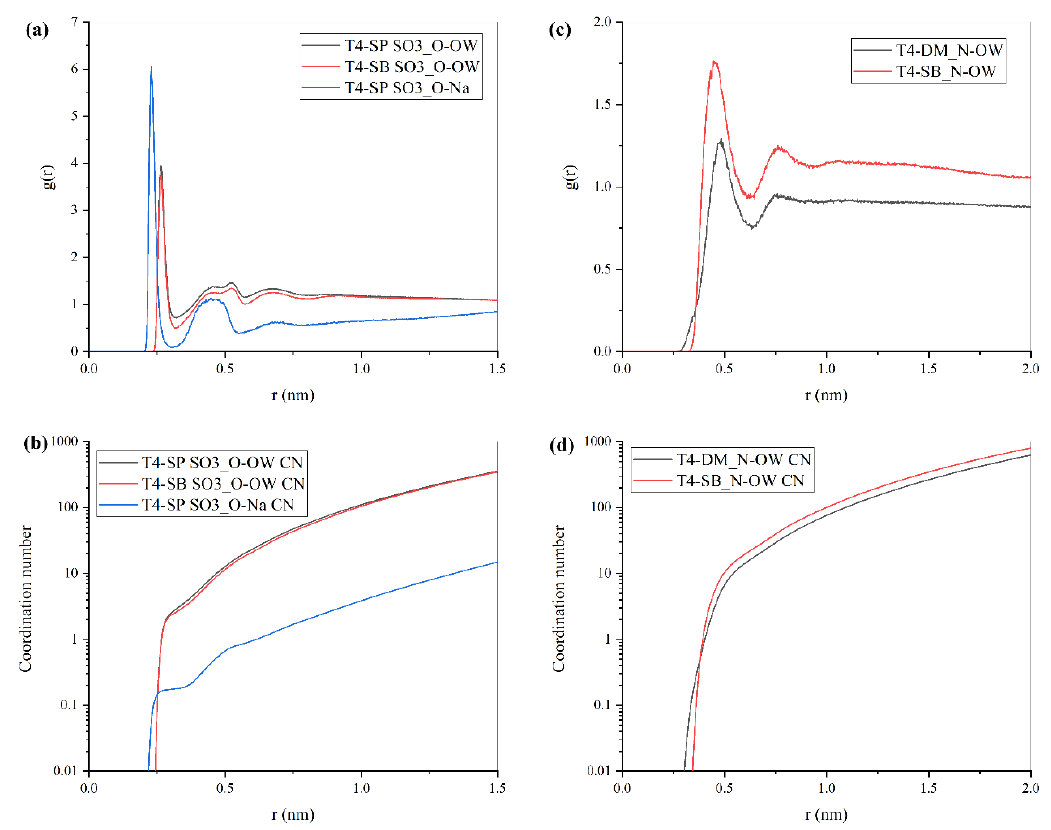
Figure 10. Radial distribution functions (RDFs), g(r) of hydration groups on antifouling membrane surface, and the cumulative number. ( a ) RDF of SO 3 − _O-OW and SO 3 − _O-Na + , oxygens in SO 3 − groups as referenced atoms. ( b ) RDF of N-OW, nitrogen atoms as referenced atoms. ( c ) Cumulative number of SO 3- _O-OW and SO 3 − _O-Na + . ( d ) Cumulative number of N-OW.